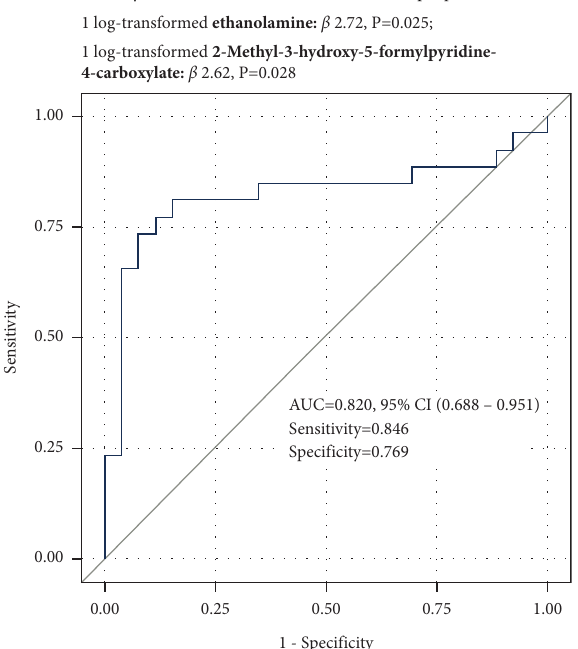
Figure 3: ROC analysis of two metabolites, including ethanol- amine and 2-methyl-3-hydroxy-5- formylpyridine-4-carboxylate, for identification of children with